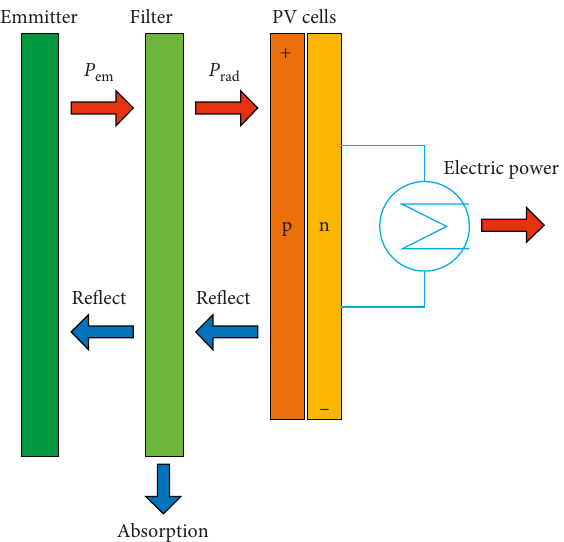
1: Energy conversion process of a micro- thermophotovoltaic (TPV)